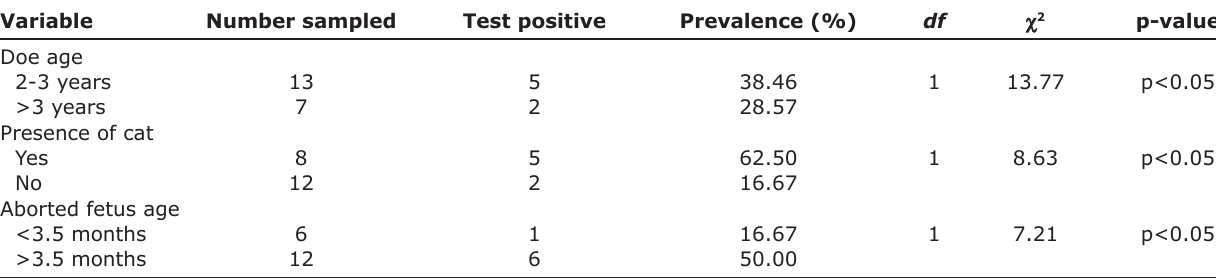
Table-5: Distribution of categorical variables among Toxoplasma gondii positive aborted fetus of goat.